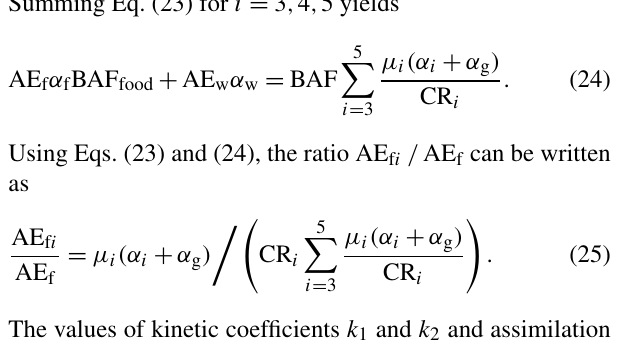
Table 2. The food assimilation efficiency AE f (Pouil et al., 2018), assimilation efficiency of elements from water AE w , tissue assimi- lation efficiencies AE f i and trophic transfer factor (TTF) for several elements. Element